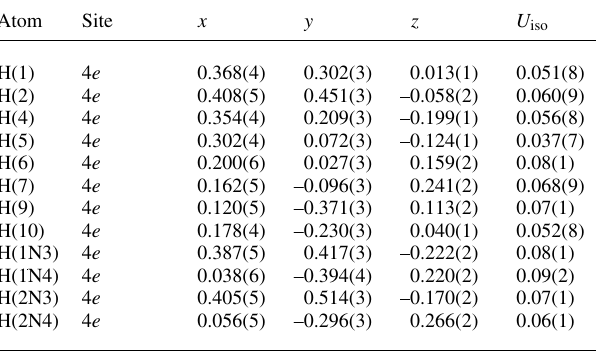
Table 2. Atomic coordinates and displacement parameters (in Å 2 )